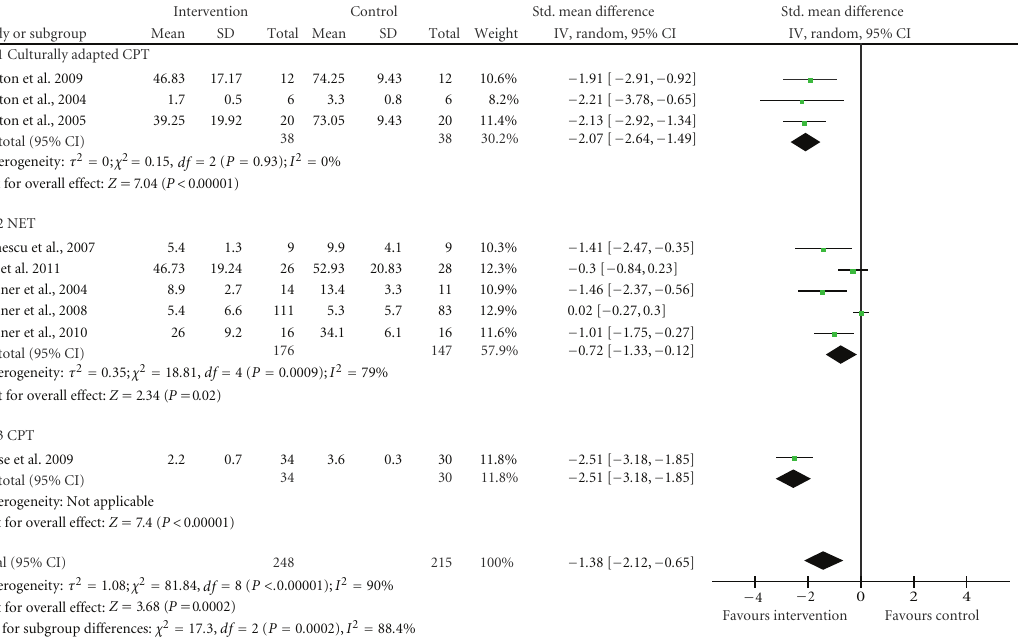
Figure 2: Forest plot of subgroup analysis culturallyadapted CPT versus NET versus CPT; Outcome: PTSD severity.